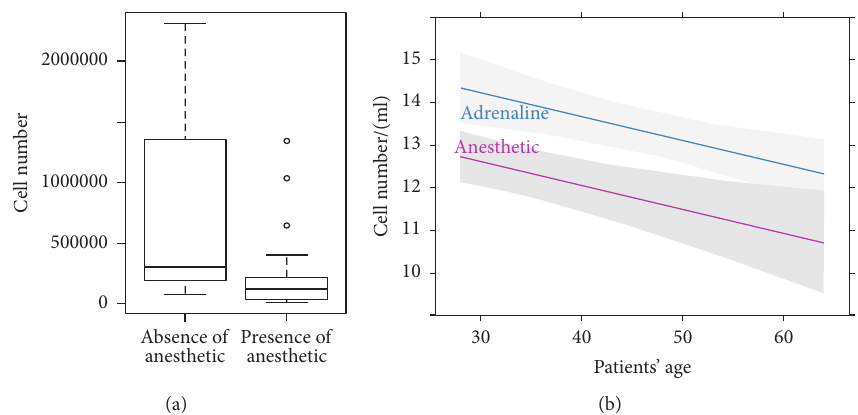
Figure 2: Local anesthetic reduced ATD-MSCs growth. (a) Box and whisker plot showed a significant difference in the number of cells isolated from adipose tissues harvested with or without anesthetic. (b) The regression analysis showed that, after 7 days, the number of cells grown in culture was reduced when the anesthetic was added to the solution of infiltration, particularly in relation to the increasing of the patients’ age, 𝑝 < 0.001 .